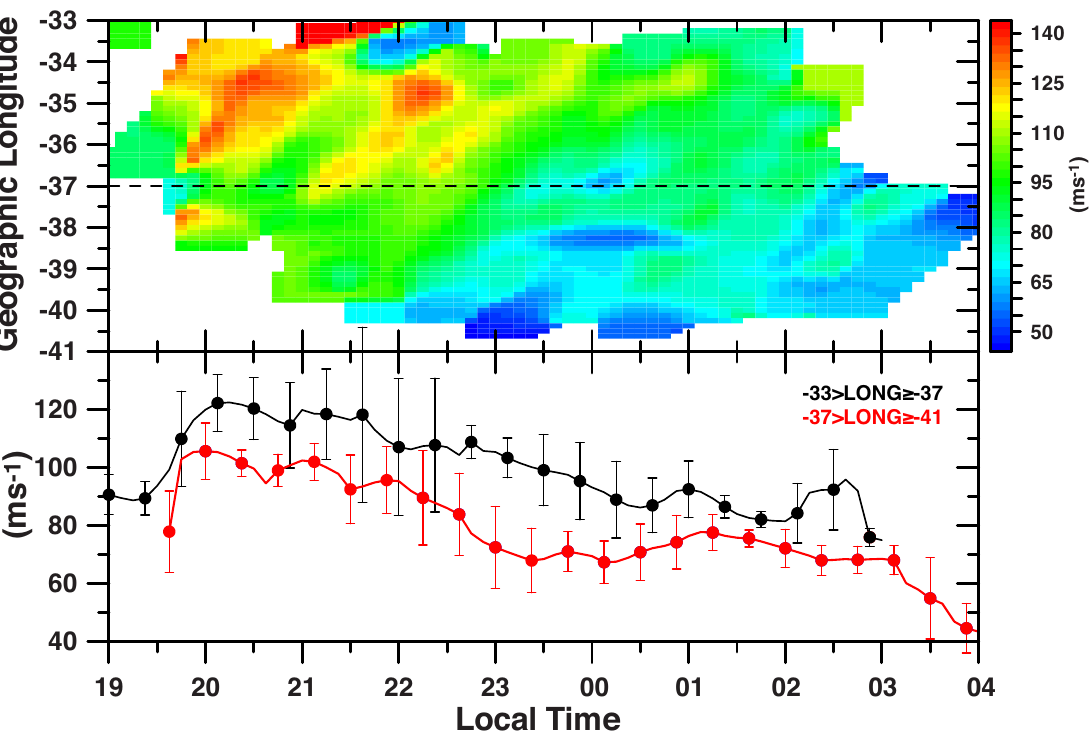
Figure 5. ( Top ) Zonal drift velocity versus local time and geographic longitude for the Cariri observatory. ( Bottom ) Drift velocity versus time along distinct longitude